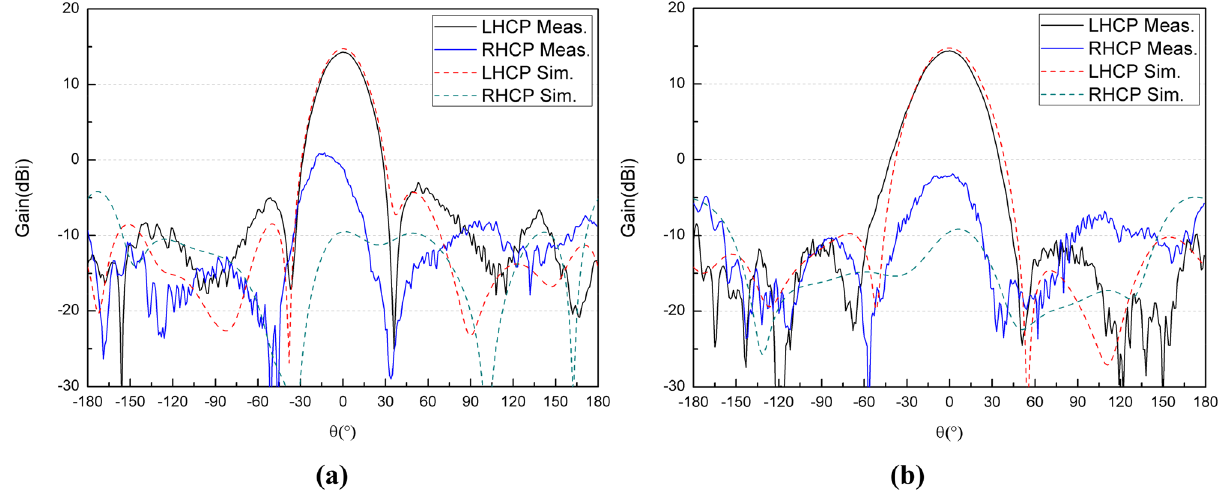
Figure 9. Comparison of measured and simulated gain radiation patterns of the feed: (a) the elevation and (b) the azimuth.